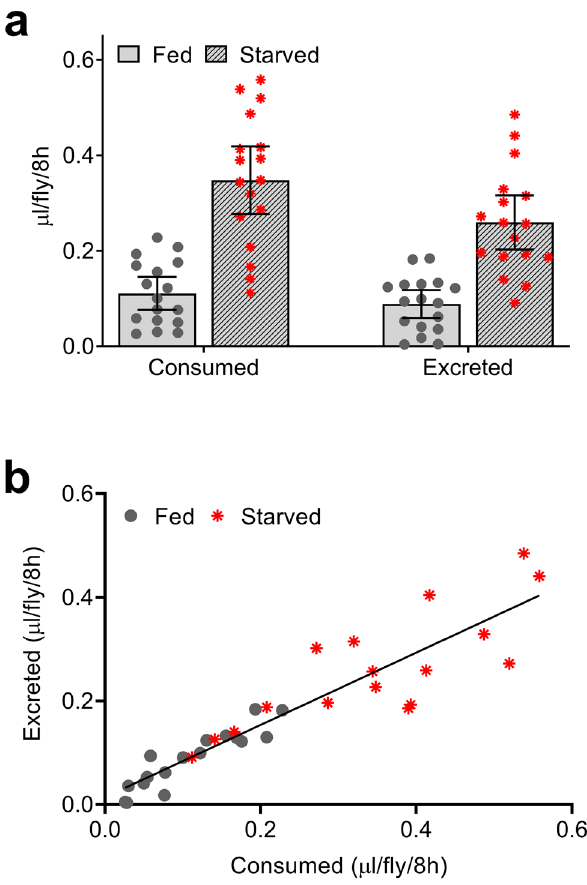
Figure 6. Coupled CAFE:excretion with Orange 4. ( a ) Consumption and excretion of liquid food labeled with Orange 4. GL females were fed standard medium or starved on 1% agar for 18 h, fed 5% sucrose liquid medium labeled with 1% w/v Orange 4 for 8 h via capillary tubes (to measure consumption via CAFE), and then provided with 5% sucrose without dye for 16 to excrete consumed Orange 4 (determined as ExVial + ExPlug). Starvation and measurement method significantly affected the volume of food consumed or excreted (repeated measures two-way ANOVA; matching consumption and excretion values within each vial, p < 0.0001; starvation, p < 0.0001; method, p < 0.0001; interaction, p = 0.0036; n = 17). ( b ) Correlation between consumption and excretion measured in panel A. Each data point represents a single vial. Consumption measurements (X-axis) and excretion measurements (Y-axis) correlated (Pearson r, R 2 = 0.8395, p < 0.0001, n = 34). Line is best-fit simple linear